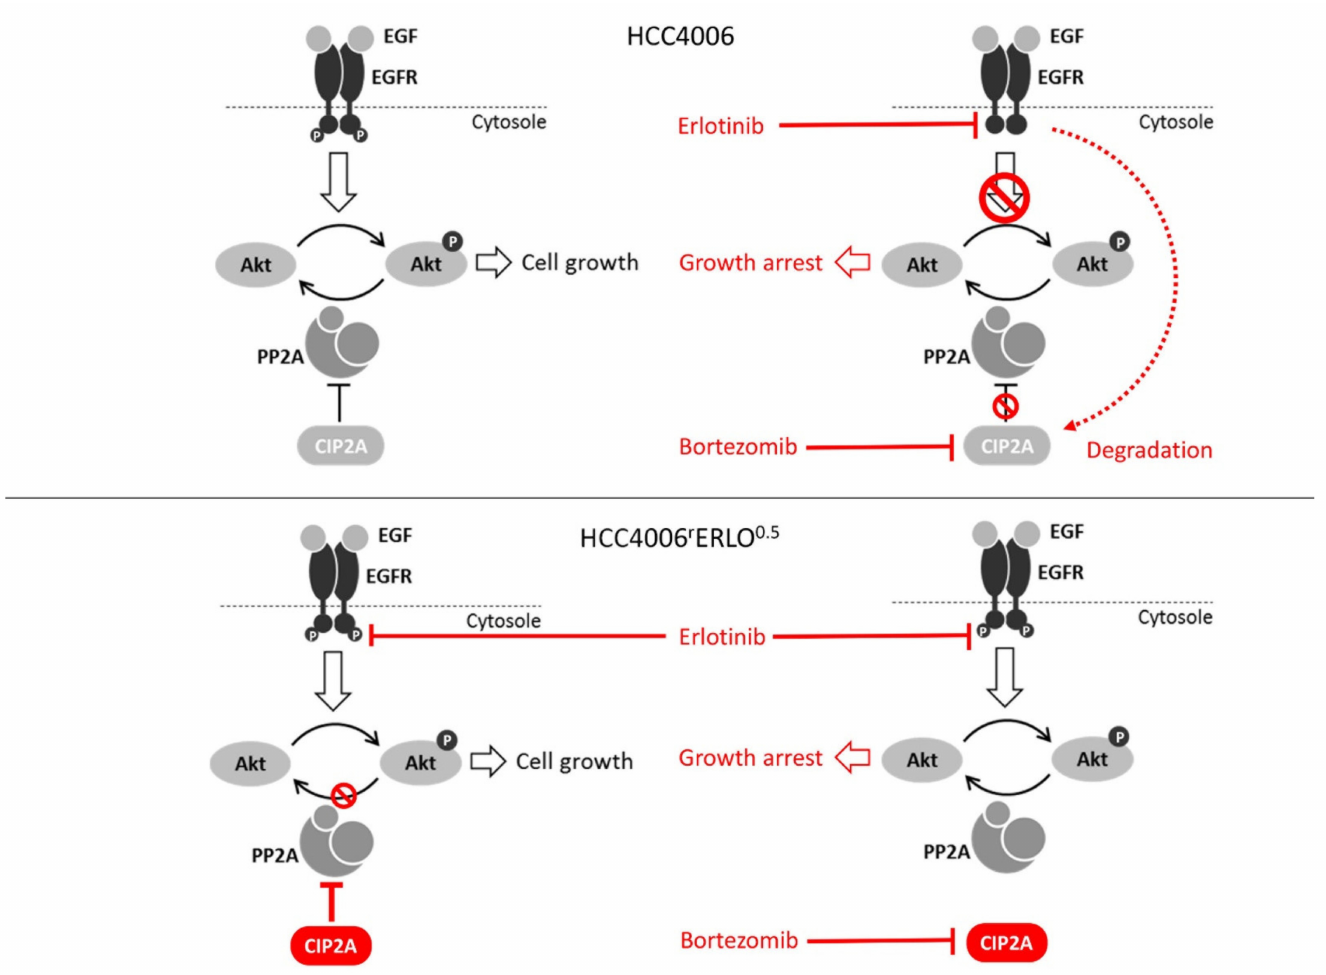
Figure 6. Schematic of the proposed mechanism of drug resistance of HCC4006rErlo0.5 cells developed against